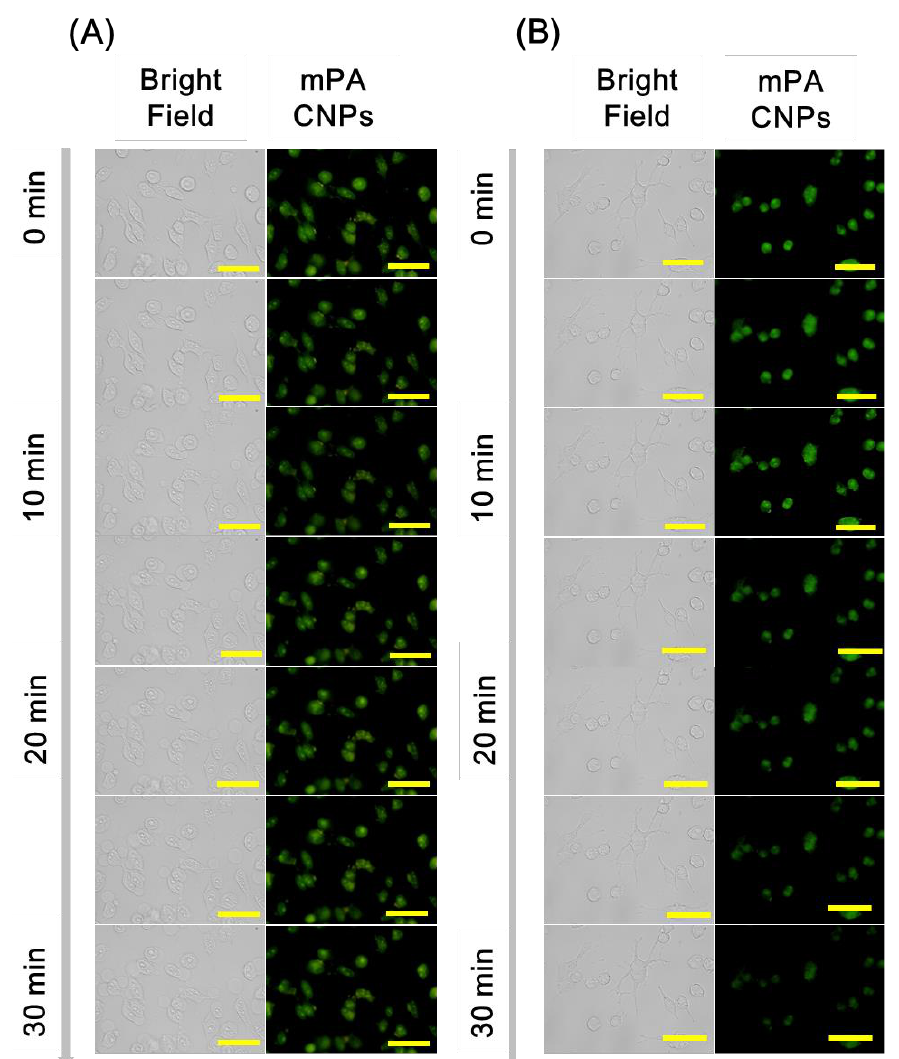
Figure 5. Fluorescence microscopic images of Tramp C1 cells incubated with mPA CNPs (5 µ g mL − 1 ) in DMEM medium (pH 7.4) for 2 h. Afterwards, the stained cells were stimulated with PBS in ( A ) the absence of and ( B ) the presence of 10 μM NaClO. Fluorescence images were collected at different time spans from 0 to 30 min. From left to right are different channels: bright field and green channel (λ ex = 470‒490 nm, λ em = 520 nm). The scale bar denotes 32 μm.